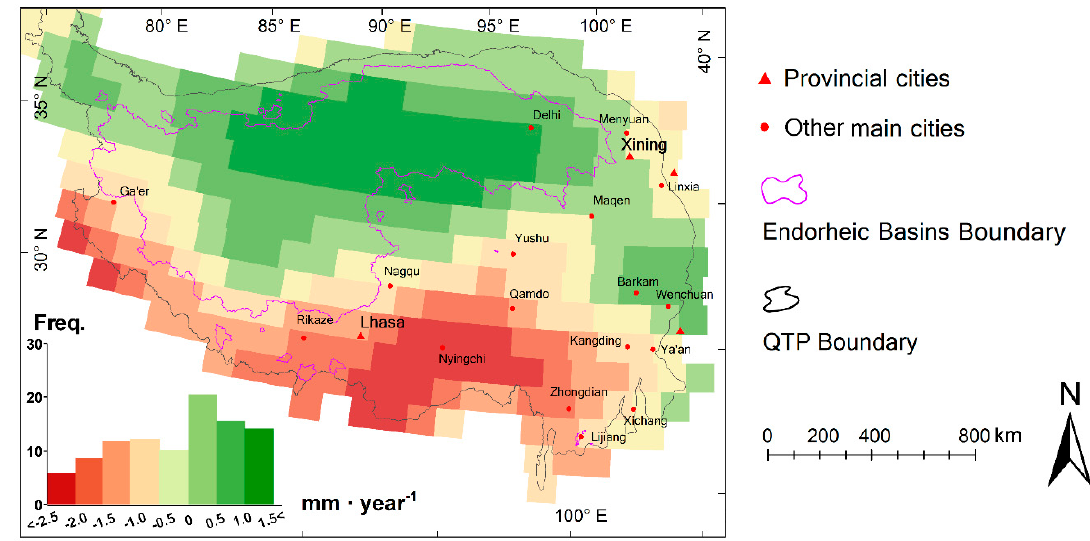
Figure A2. Spatial patterns of the trends of annual mean TWS anomalies from 2003–2015 (the trend was calculated using the R statistical software; maps and histograms were created using ArcMap 10.6, ESRI, CA).